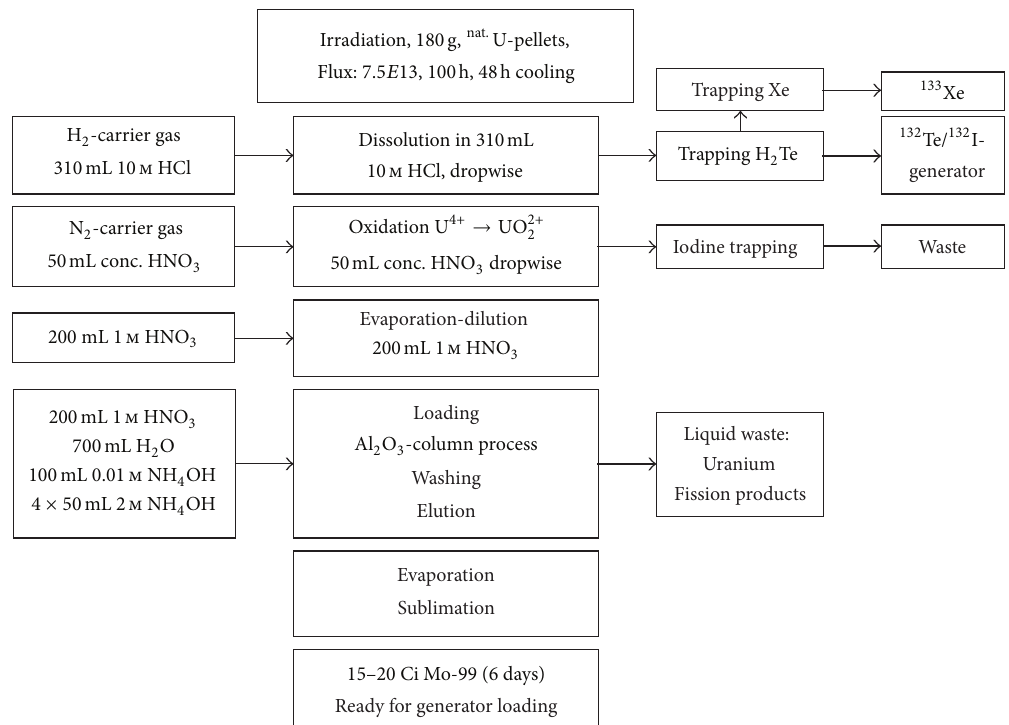
Figure 2: Process scheme (taken from [19]) describing one of the first industrial production processes for small-scale fission Mo-99 production (now called LITEMOL).